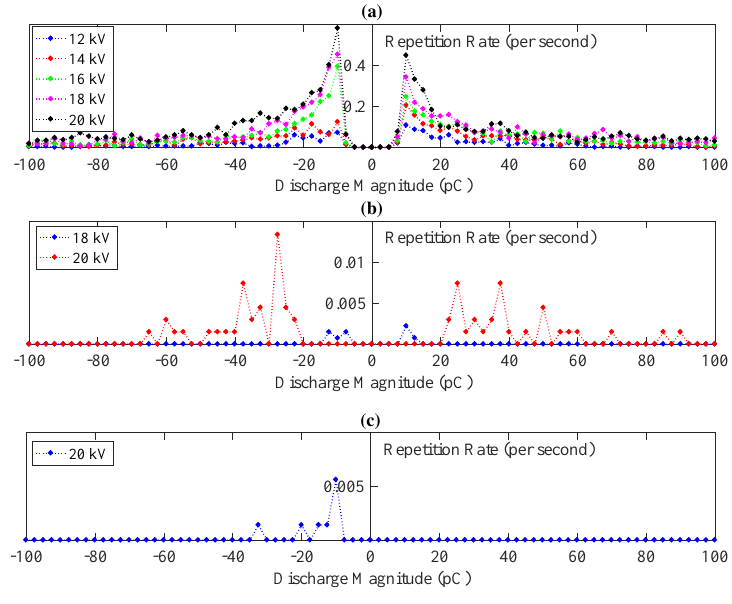
Figure 13. PD discharge magnitude versus repetition rate for different voltages in ‘Test Series 3’ ( a ) 0.1 Hz; ( b ) 0.01 Hz; ( c )